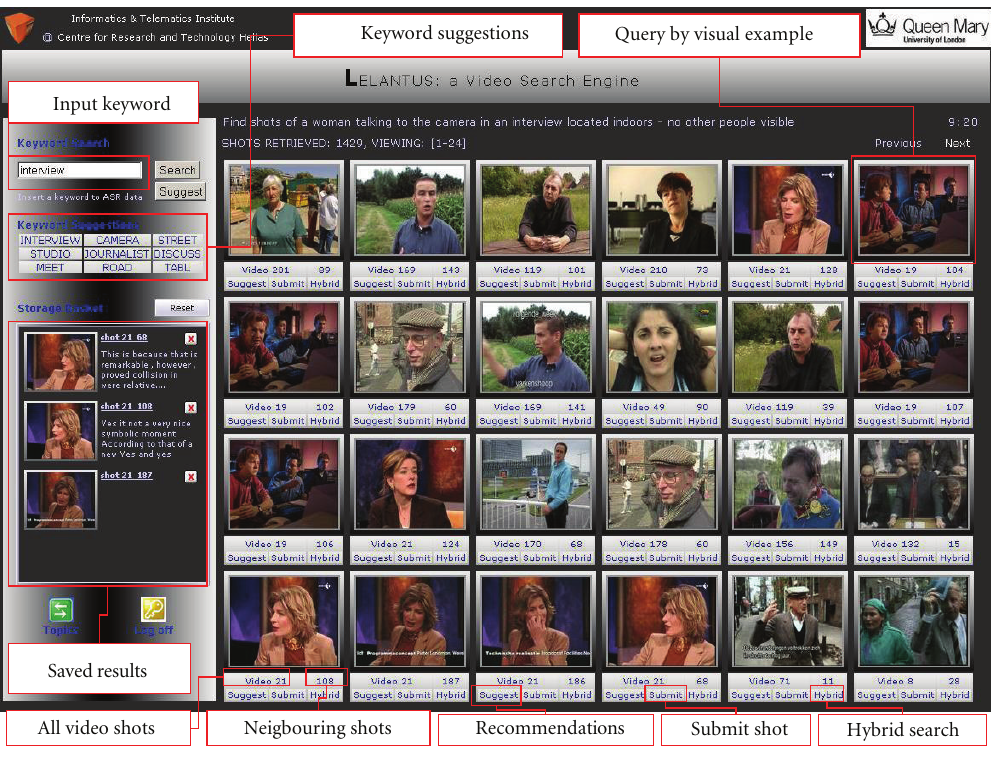
Figure 7: Search engine interface.